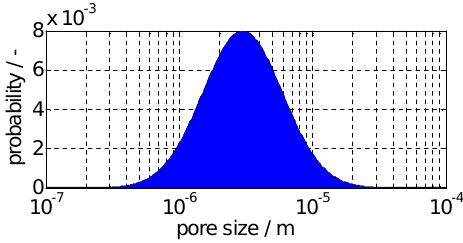
Figure 14. Pore size distribution model (log-normal distribution: σ = 0 . 3µ = 3 × 10 − 6 m in analogy to that of the Rotliegend sand- stone shown in Fig.